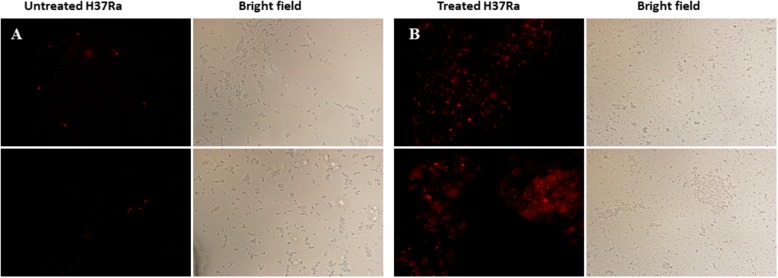
Fluorescence microscope images of membrane permeabilization. M. tuberculosis H37Ra was observed with red fluorescence of permeable PI when the integrity of the cell walls was destroyed. Untreated M. tuberculosis H37Ra (A) showed obvious red fluorescence than treated with dicumarol (12.5 μg/ml) (B).